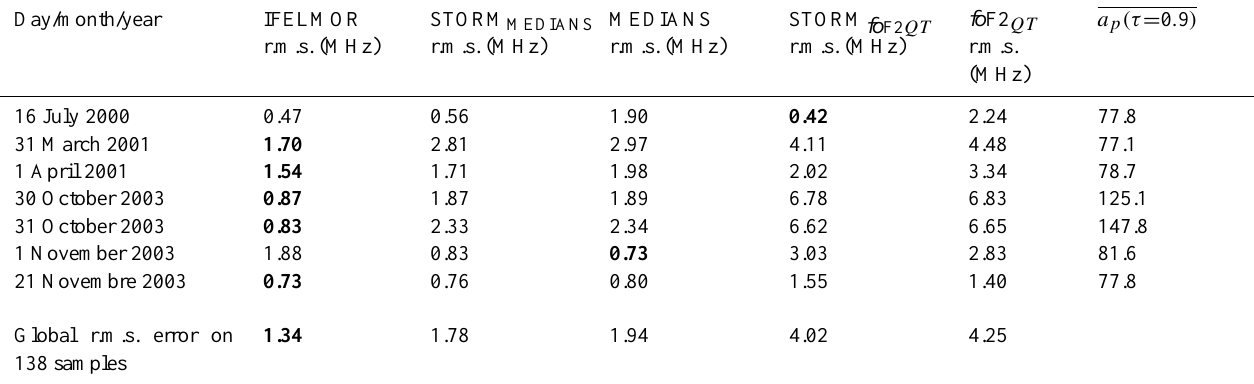
Table 5. Comparisons in terms of r.m.s. for the days selected under disturbed ionospheric conditions with a p (τ = 0 . 9 )> 70; the best perfor- mance is labelled in